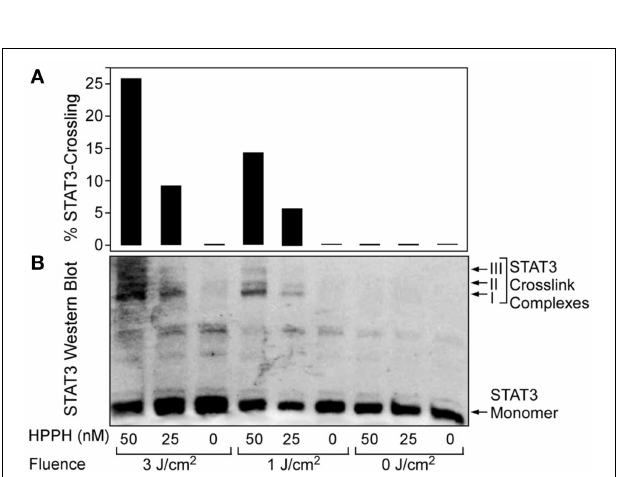
FIGURE 5 | STAT3 crosslinking is affected by both drug and light dose. SCCVII cells were subjected to HPPH PDT under conditions as indicated at the bottom. (A) Graphical representation of the relative level of STAT3 crosslinking as a function of HPPH concentration and delivered light fluence. (B) Western blot images showing the PDT-dependent formation of STAT3 dimer